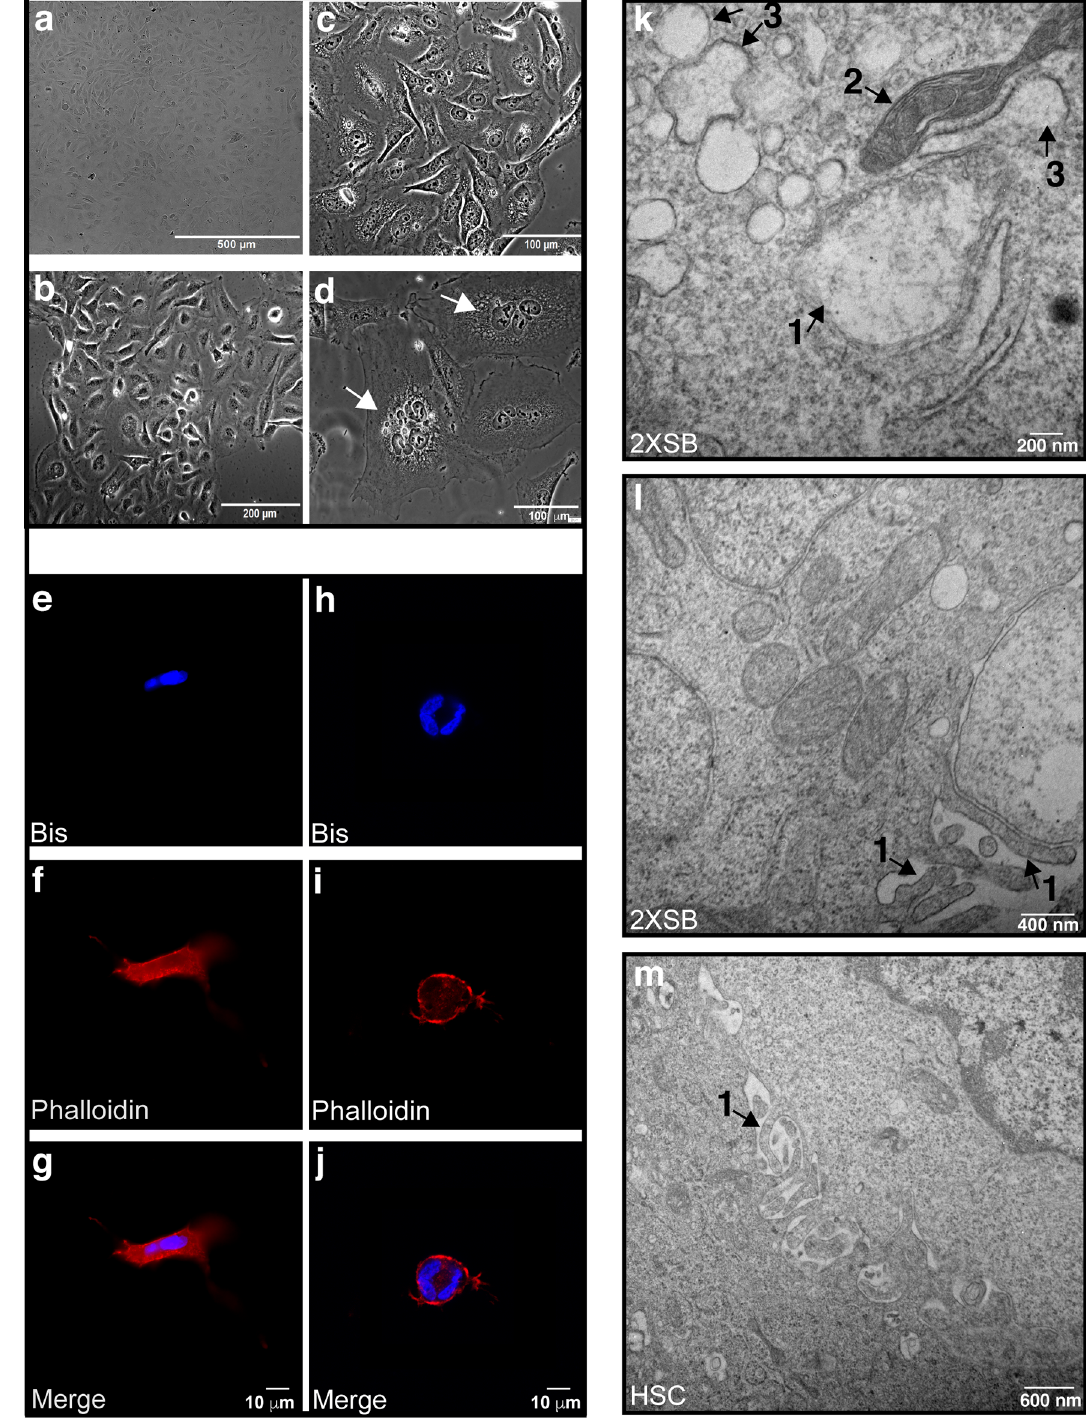
Figure 2. The morphology of the 2XSB sporadic MPNST cell line recapitulates the pattern seen in the parent tumor. ( a–d ) Representative brightfield ( a ) and phase contrast ( b – d ) images of logarithmic phase 2XSB cells. Both brightfield and phase contrast microscopy show that the tumor cells have a cobblestoned to spindled morphology. Note also that the ×60 phase contrast images in ( c ) show several cytoplasmic vacuoles in the tumor cells, while ( d ) illustrates two representatives of the subpopulation of large multinucleated cells present in this line (arrows). ( e–j ) Two representative 3D culture images ( g , j ) show the merged nuclei and cytoskeleton images acquired at ×63 with z-stack microscopy highlighting spindled ( e–g ) and polygonal ( h–j ) multinucleated cells. Panels ( e–i ) show the individual channels acquired for phallodin-Texas Red (cytoskeleton labeling, f , i ) and DNA-bisbenzamide (nucleus labeling, e , h ) prior to merging in panels ( g ) and ( j ). ( k–m ) Transmission electron microscopy ( k ) demonstrates that 2XSB cells contain swollen (1) and normal (2) mitochondria and swollen rough endoplasmic reticulum (3). Both 2XSB cells and non- neoplastic human Schwann cells also have numerous microvilli on their cellular surfaces (1 in l , m